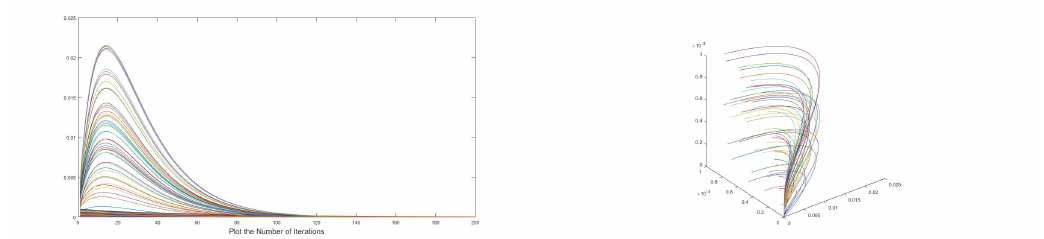
Fig. 3 Left: Locally asymptotically stable trajectories and in Right: the 3D plot of the trajectories of the equilibrium point (0,0,0) where the initial values are taken from the neighbourhood of the